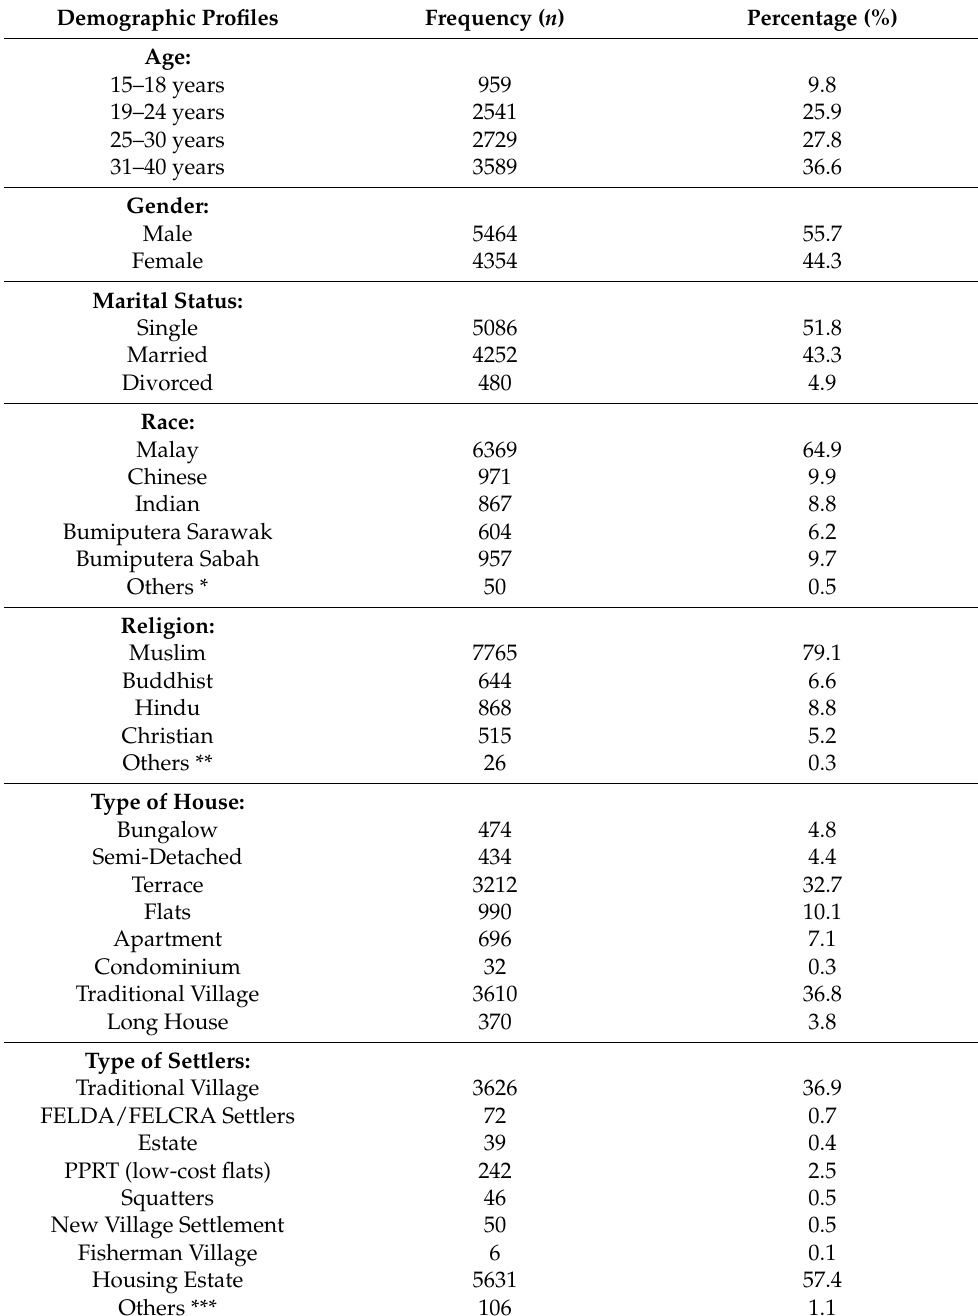
Table 1. Malaysian youth demographic profiles ( n = 9818). Demographic